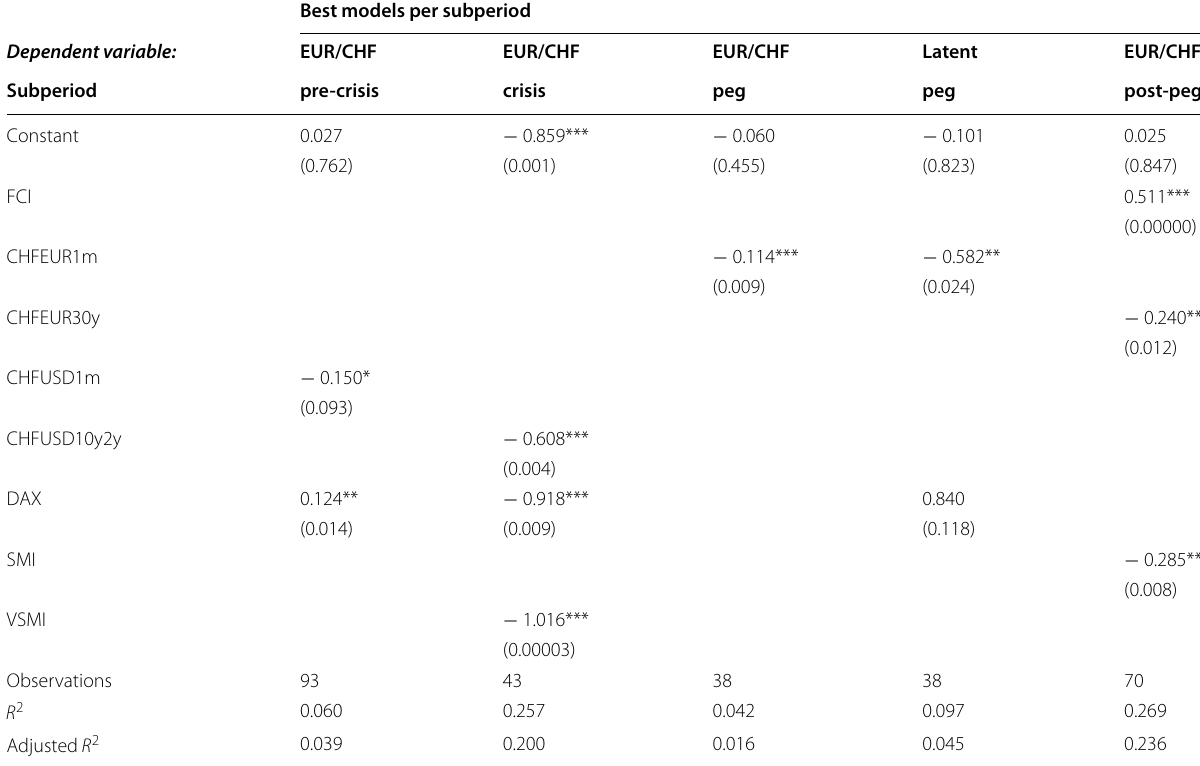
p values (in parentheses) and corresponding significance stars are based on Newey–West adjusted standard errors with 6 lags, where the lag order was determined based on a full-sample